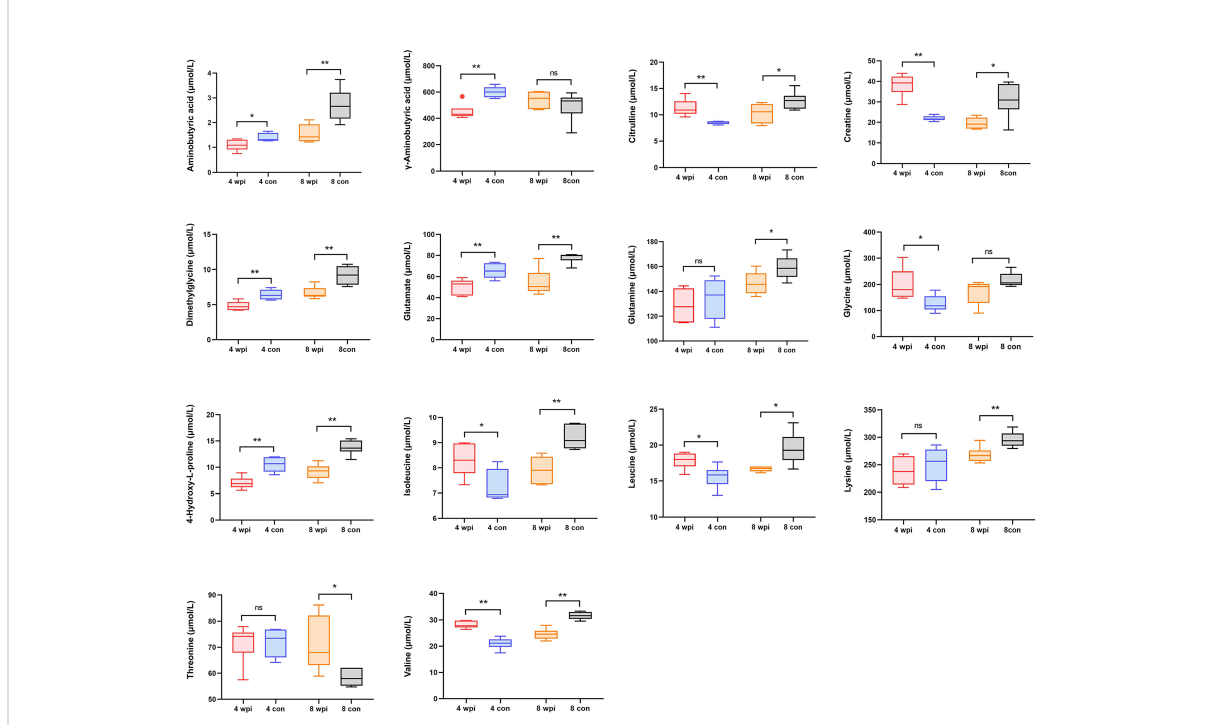
FIGURE 3 The concentrations of 14 signi fi cantly changed amino acids in serum of different groups. * P < 0.05, ** P < 0.01, t -test. ns, no signi fi cant